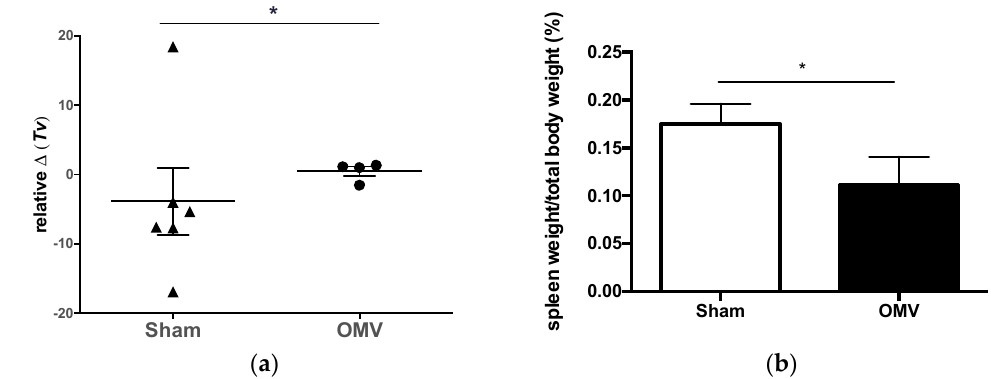
Figure 5. Immunization with B. pseudomallei OMVs provides protection against glanders disease in nonhuman primates. Pulmonary function of rhesus macaques vaccinated with OMV or saline (sham-vaccinated). ( a ) Relative change ( Δ ) in tidal volume (mL/breath) prior to challenge when compared to measurement +7 days after B. mallei aerosol challenge. Group comparison by Kolmogorov-Smirnov test, significance at * p < 0.05; ( b ) Spleen weight over total body weight was calculated as a percentage to quantify degree of splenomegaly (* p < 0.05). Table 1. Pathological findings in sham- and OMV-immunized macaques infected with B. mallei .